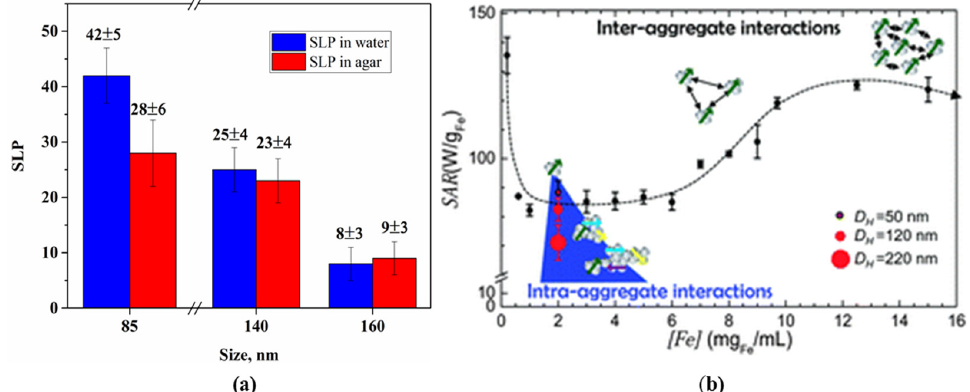
Figure 11. ( a ) SLP for water and agar dispersions of magnetite-based multicore particles as a function of hydrodynamic size in AMF of 1048 kHz and 5.8 kA/m [93]; ( b ) Effect of intra and intercluster magnet–dipole interactions in the dispersion of magnetite NPs on SAR as a function of concentration and hydrodynamic cluster size (D H ) obtained under the given AMF conditions of 105 kHz and 13.1 kA/m [111]. Reprinted with permission [93,111]. Copyright 2021, Elsevier and Royal Society of Chemistry.